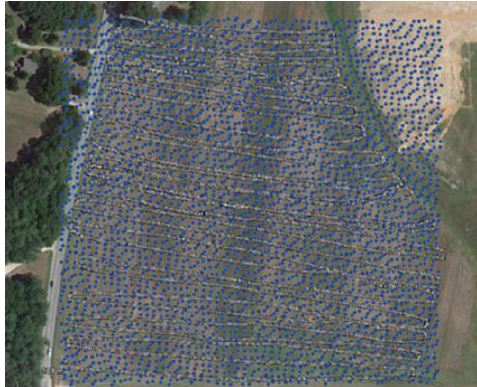
Figure 3. Bare earth lidar data and GPS data on project site The other point between these point data sets is that GPS data are less sensitive than bare earth lidar data. Mobile device’s GPS driver can measure only half meter elevation differences but lidar data can measure 1 centimeter elevation difference on the ground. That means Lidar data are 500 times sensitive than GPS elevation points.